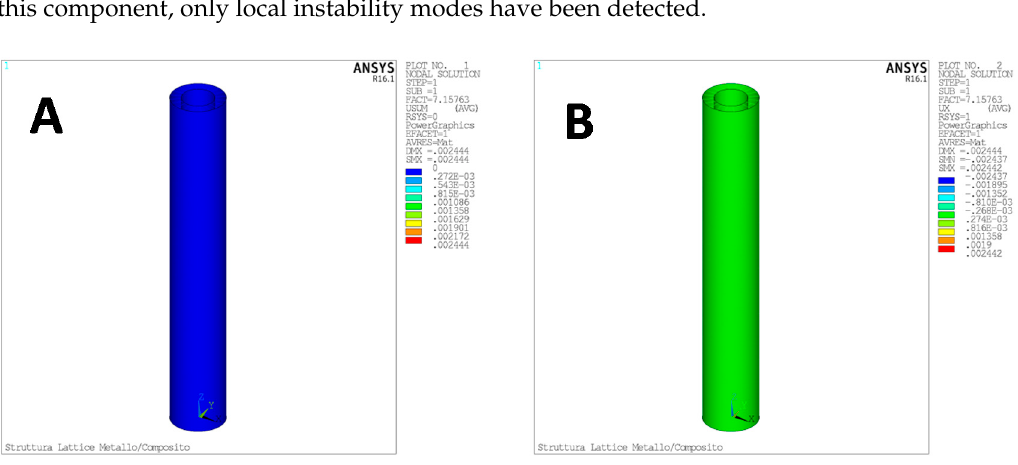
Figure 29. Test Case 3—1st buckling mode. ( A ) Total Displacement in Cartesian reference system; ( B ) radial displacement in cylindrical reference